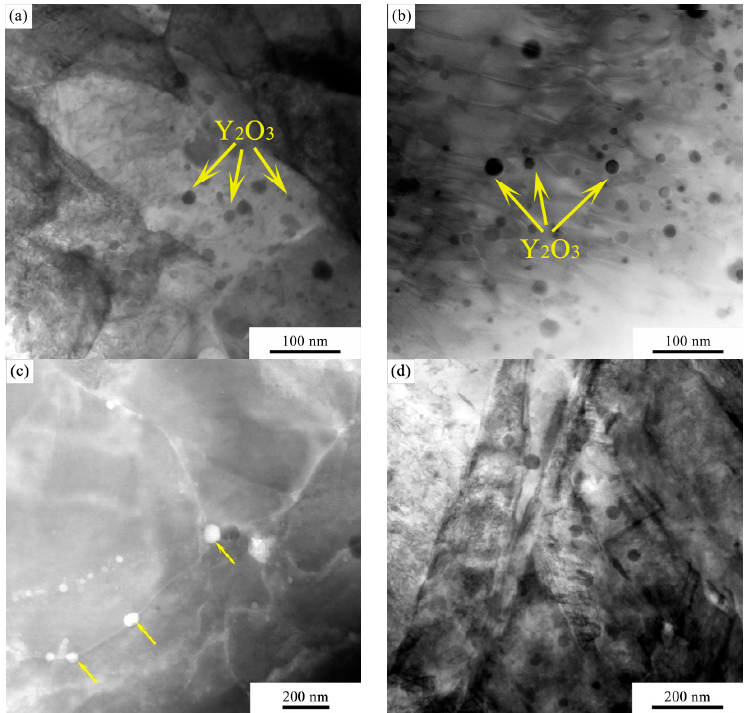
Figure 5. TEM images of the Y 2 O 3 nanoparticles in the ( a ) base material, ( b ) fusion zone, ( c ) Y 2 O 3 pinning the grain boundaries and ( d ) martensite lath.